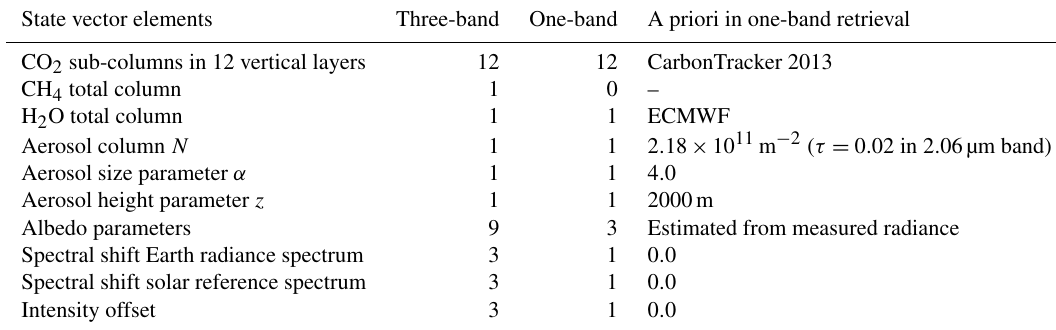
Table 1. State vector elements for the three-band and one-band retrievals.